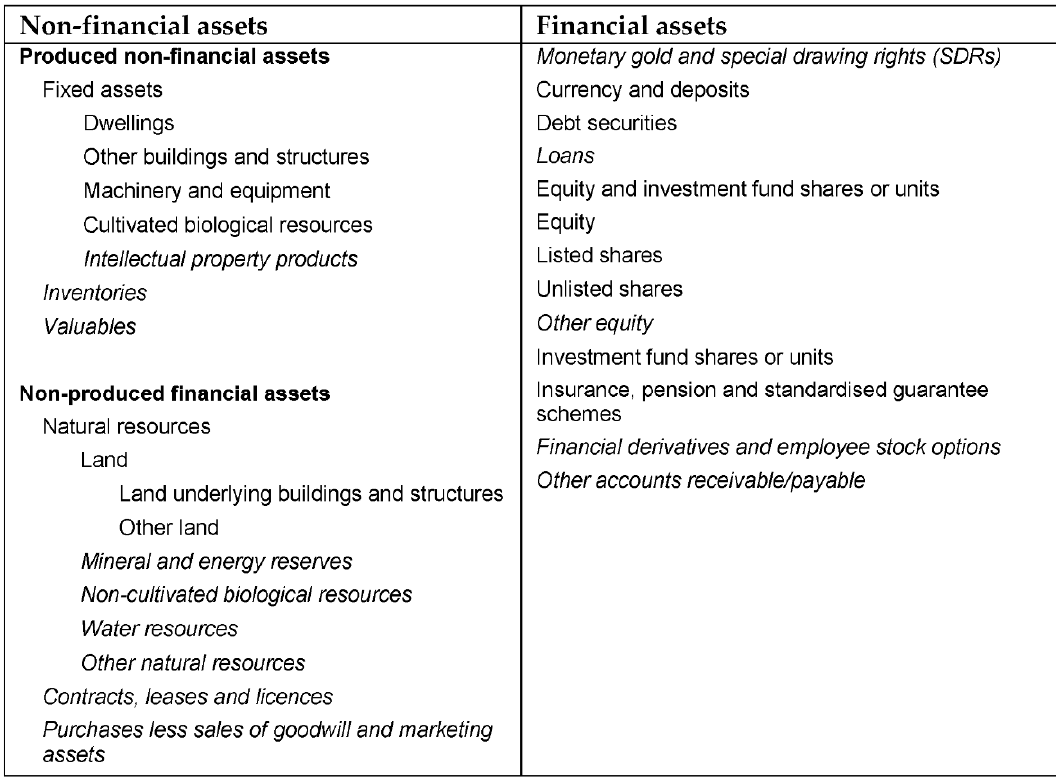
Figure 1. Asset side of a stylized household sector balance sheet according to European System of Accounts (ESA) 2010. Note: all assets in italics were not included in the real return computation. Source: authors’ illustration based on European Commission (2013).